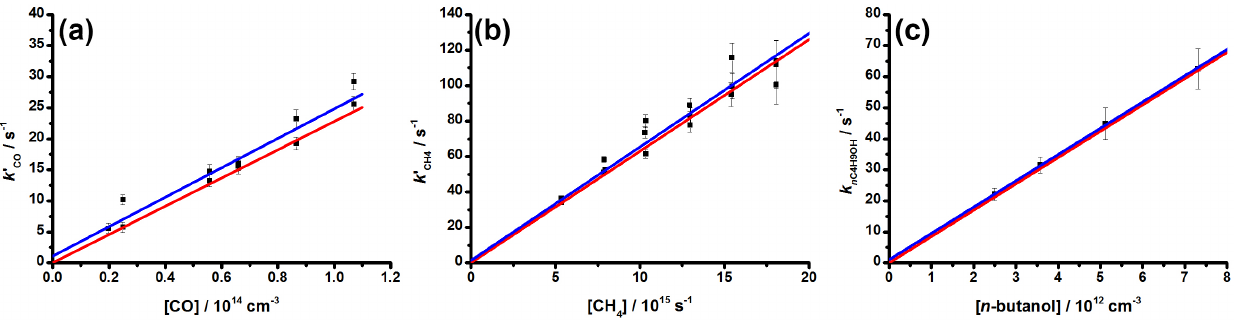
) against known concentrations of reactive gases Figure 4. Bimolecular plots of pseudo-first-order rate coefficients describing OH loss ( k (cid:48) OH during laboratory tests (black points) with best fit lines (blue) and literature values (red) for (a) CO at 298K (intercept = 1.1s − 1 ) ; (b) CH 4 at 298K (intercept = 1.3s − 1 ) ; (c) n -butanol ( n -C 4 H 9 OH, sampling from the chamber) at 298K (intercept = 1.1s − 1 ) . Literature values are taken from Atkinson et al. (2004). Corrections for dilution have been applied (Eq. 7). Errors are 1 σ from the fits to the observed OH decays. Note the change in vertical scale between the three